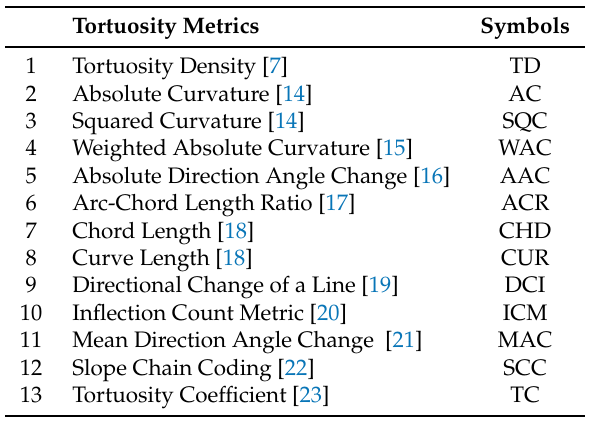
Table 1. Summary of tortuosity